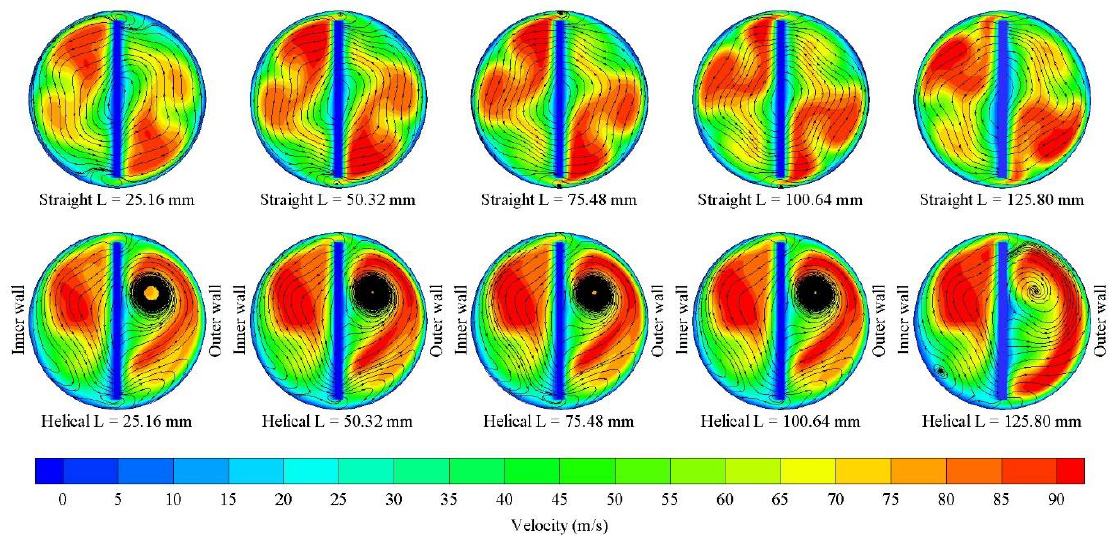
Figure 7. Axial velocity profile (contour, m / s) and streamlines of reactant flow in straight and helical reactors with insert tape twisting ratio of 3.15 at the outlet and inlet Reynolds number of 1000.